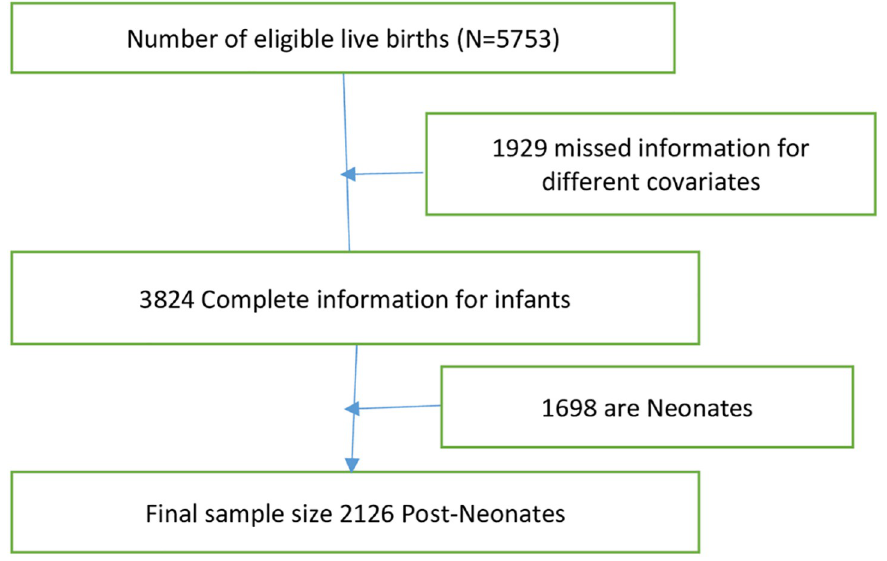
Fig 1. The way of selecting a sample in the